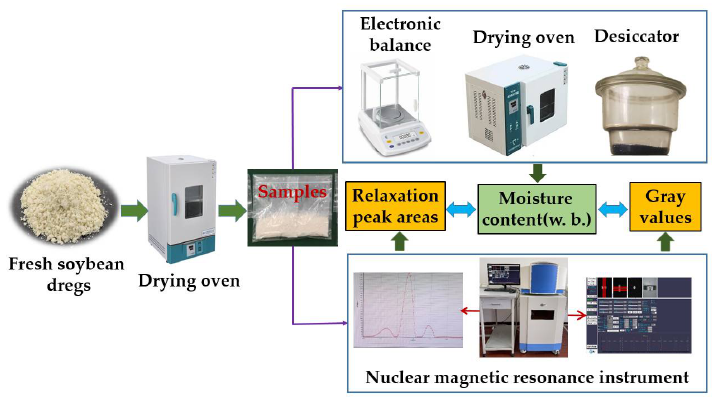
Figure 1. Drying process and moisture measurement of soybean dregs.